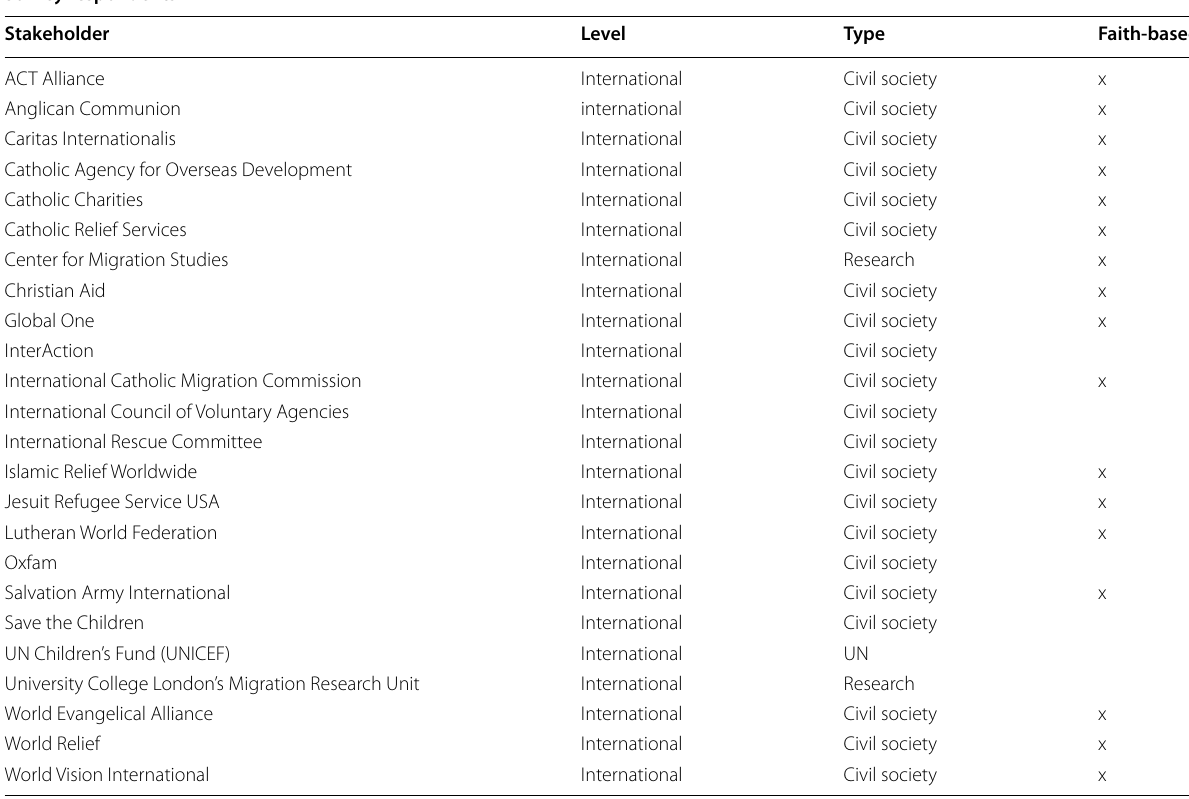
Table 1 The 24 respondents surveyed for the study Survey respondents